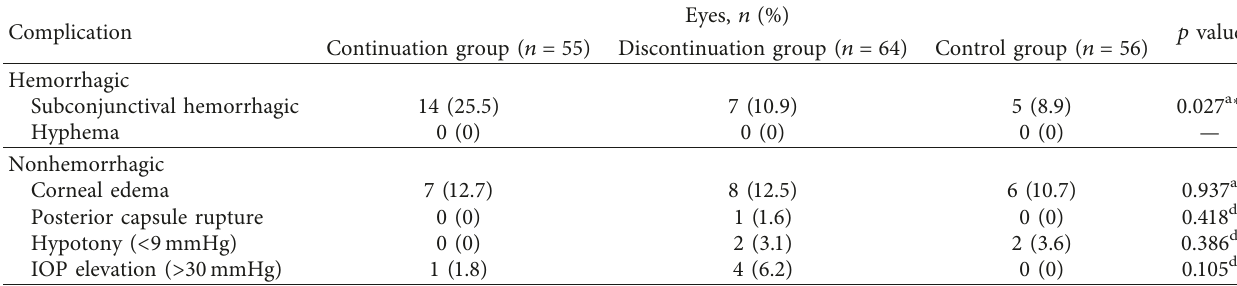
Table 5: Incidence of complications in scleral tunnel incision cases.